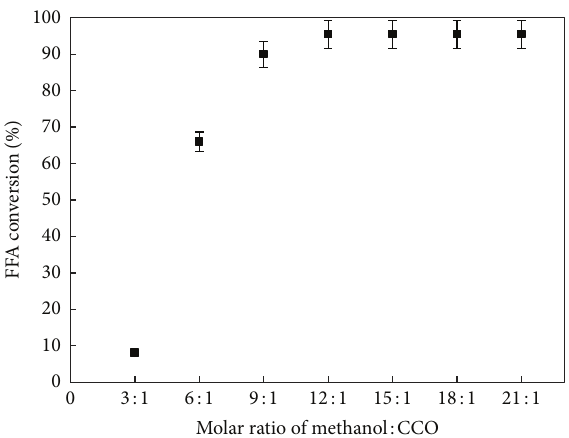
Figure 9: FFA conversion yield versus methanol/CCO molar ratio. The reaction conditions were 3.6 wt% DSIMHSO 4 , 150 ∘ C, and 600 rpm for 3 h.